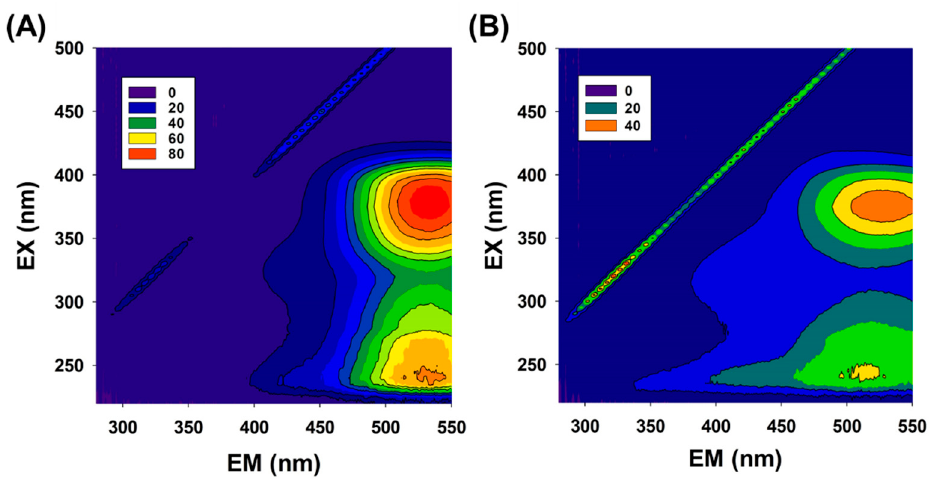
Figure 7. Excitation-emission matrix results acquired from the municipal effluent spiked with TC, before ( A ) and after ( B ) treating with Fe 3 O 4 /PS [Fe 3 O 4 ] = 1 g/L, [PS] 0 = 1 mM, [TC] 0 = 41.6 μ M).